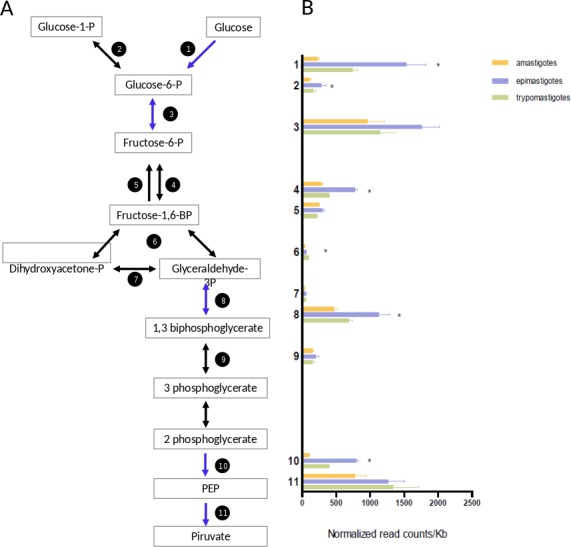
Glucose metabolism.(A) Schematic diagram of glucose catabolism. Each reaction is assigned with a number (1: hexokinase, 2: phosphoglucomutase, 3: glucose-6-phosphate isomerase, 4: phosphofructokinase, 5: fructose-1,6-biphosphatase, 6: aldolase, 7: triosephosphate isomerase, 8: glyceraldehyde 3-phosphate dehydrogenase, 9: phosphoglycerate kinase, 10: enolase and 10: pyruvate kinase 2). (B) Expression of glucose metabolism genes of each reaction is shown as normalized count per gene size in kilobases. The three cycle stages are represented: amastigotes (green), epimastigotes (blue) and trypomastigotes (orange). (*) Denotes differentially expressed genes.